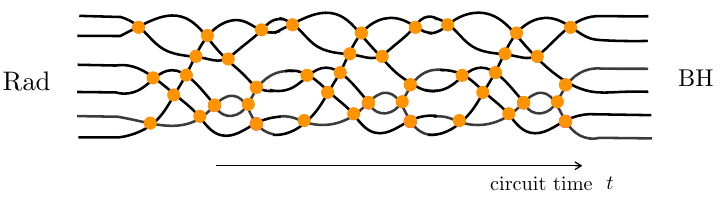
Figure 8 . A quantum circuit connecting the black hole and the radiation at around Page time.